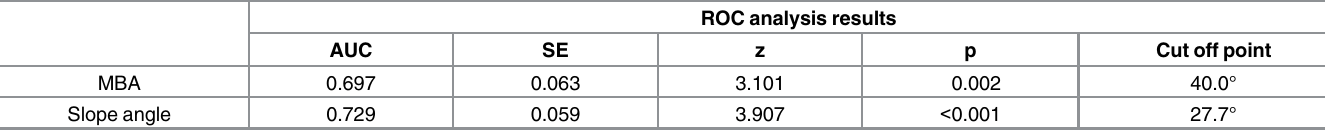
Table 5. ROC analysis results for MBA and Slope